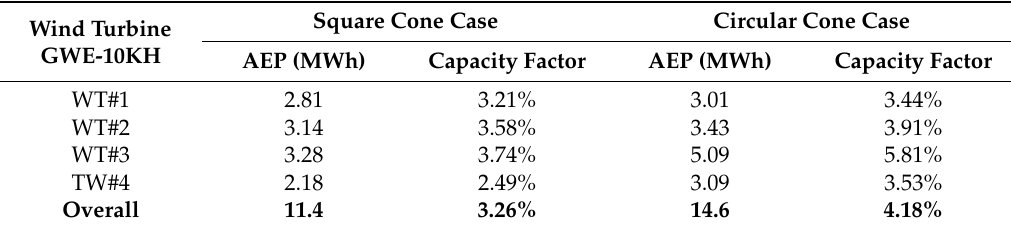
Table 1. The AEP and capacity factor of the vertical-axis wind turbines.